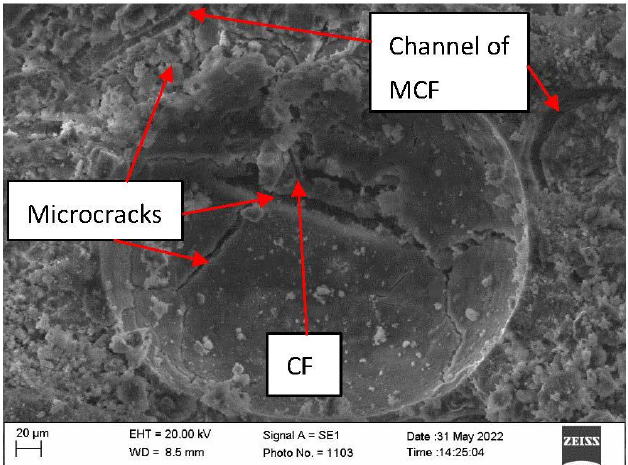
Figure 9. Microstructure of the sample AP100 before fire exposure. Research of microstructure of samples after fire temperature impact showed that in samples with CF, the amount of microcracks was higher than that in E samples (Figures 10 and 11).